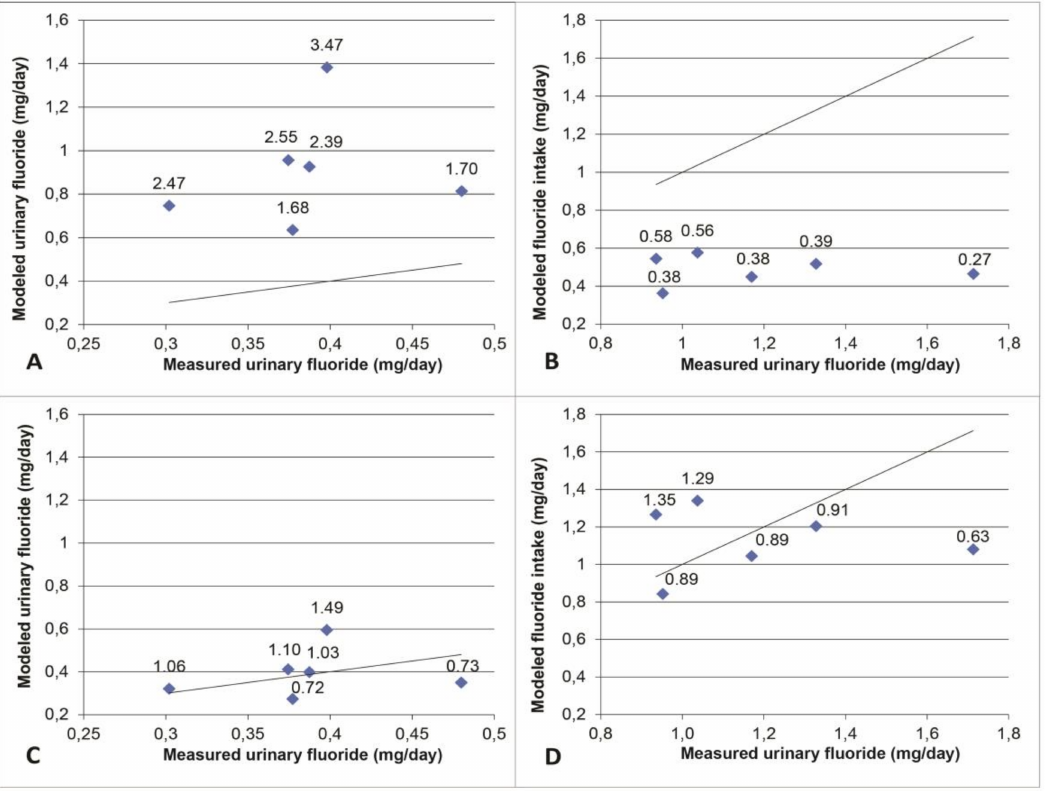
Figure 4. Results of model simulation of exposure data in the literature as a function of experimental biological measures in children aged 4 to 7 years. Each point represents a study while the line represents a perfect agreement. The values at the top of the points represent the ratios between the modeled values and the experimental values. Panels ( A , B ) illustrate, respectively, the over-estimation and underestimation of the modeled values. Panels ( C , D ) show the predicted values around the perfect agreement line when adjusted by multiplying by the adjustment factor of 0.43 in ( C ) and 1/0.43 in ( D